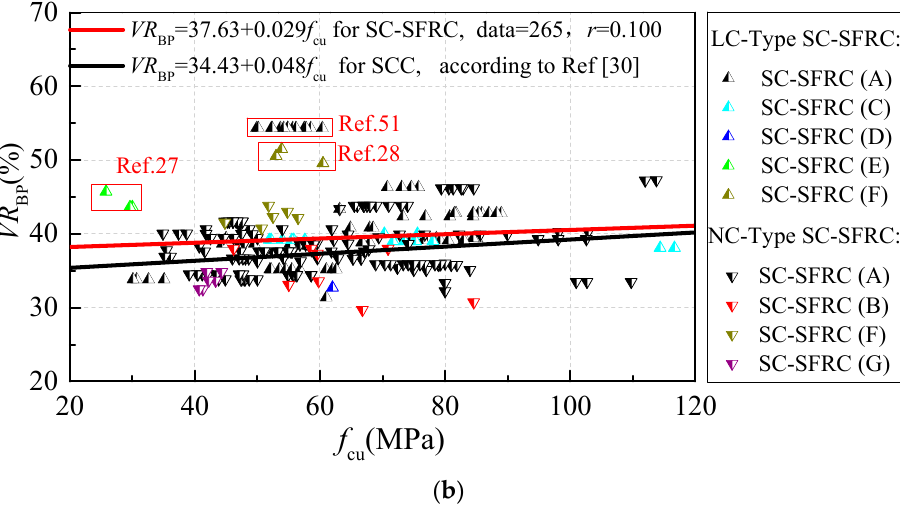
Figure 4. The differences of binder materials: ( a ) VR b ; and ( b ) VR BP .